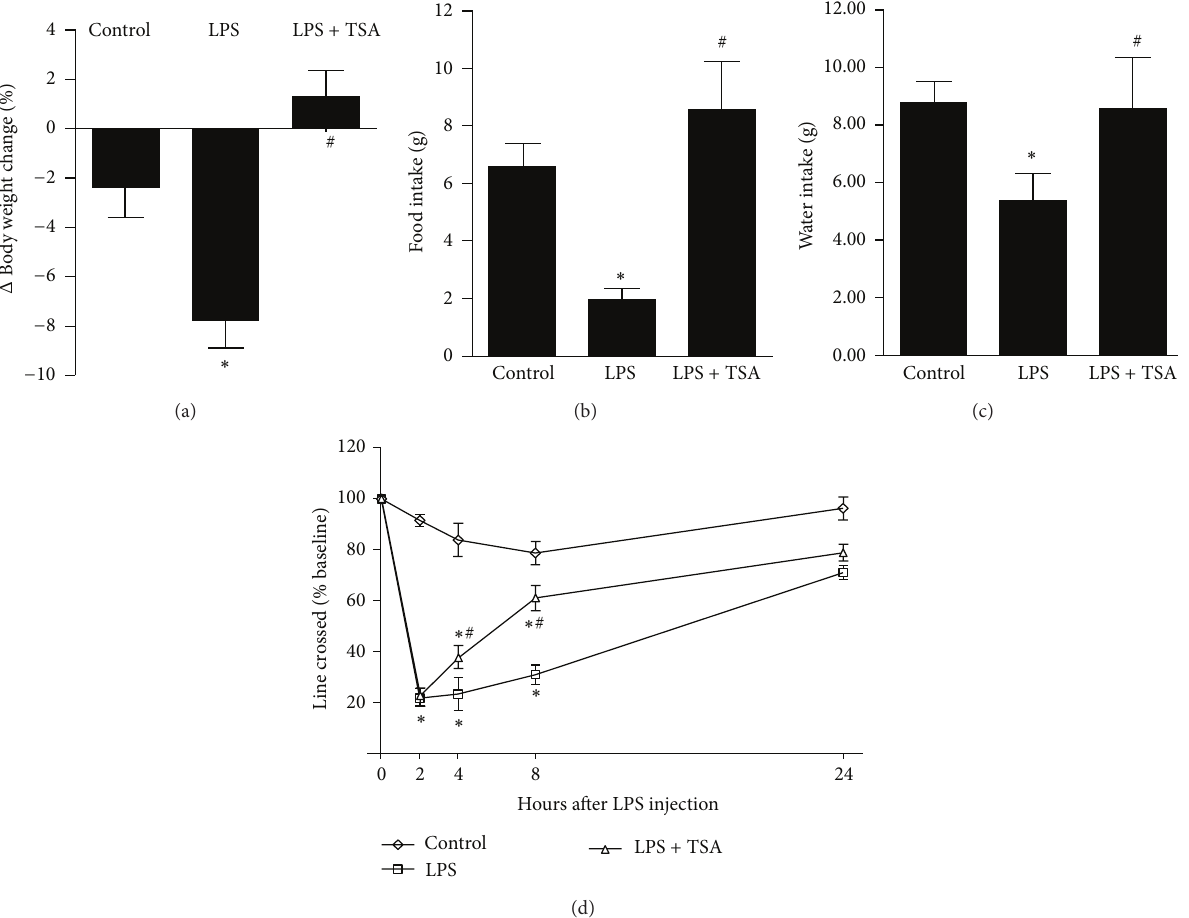
Figure 1: TSA facilitated the recovery from LPS-induced anorexia and increased line crossing (locomotor activity). Mice were pretreated with saline (Controls) or TSA (0.3 mg/kg) for 1h and then intraperitoneally challenged with saline or E. coli LPS (1mg/kg). (a) Body weight, (b) food intake, and (c) water intake were measured before an LPS injection and then again 24 h later. (d) Line crossing was measured before the LPS injection and then again 2, 4, 8, and 24 h later. Bars and graphs present means ± SEM ( 𝑛 = 6 ). ∗ 𝑃 < 0.05 compared with the Control group; # 𝑃 < 0.05 compared with the LPS-only